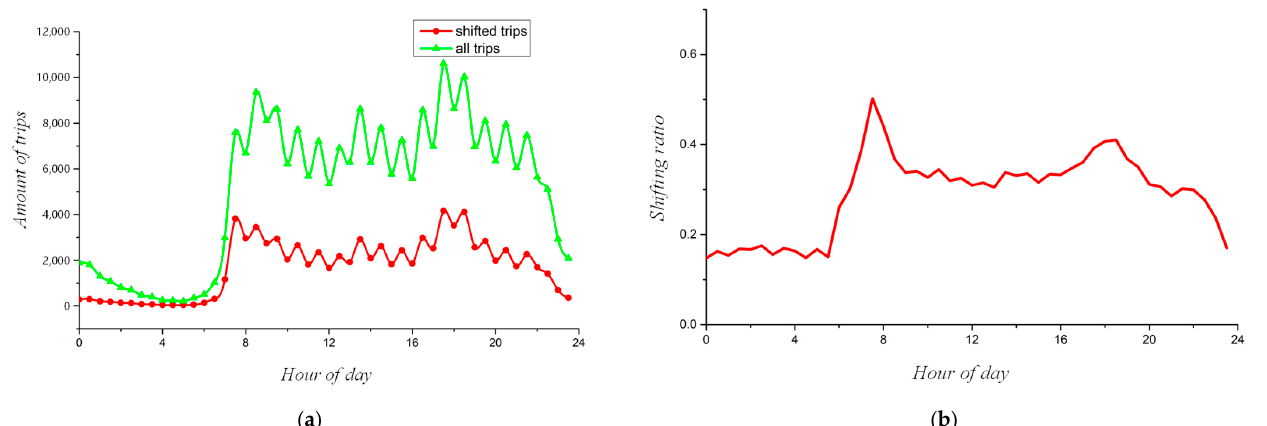
Figure 11. Potential amount and ratio of shifting from ride-hailing to shuttle service. ( a ) The potential number of trips; ( b ) shifting ratio.